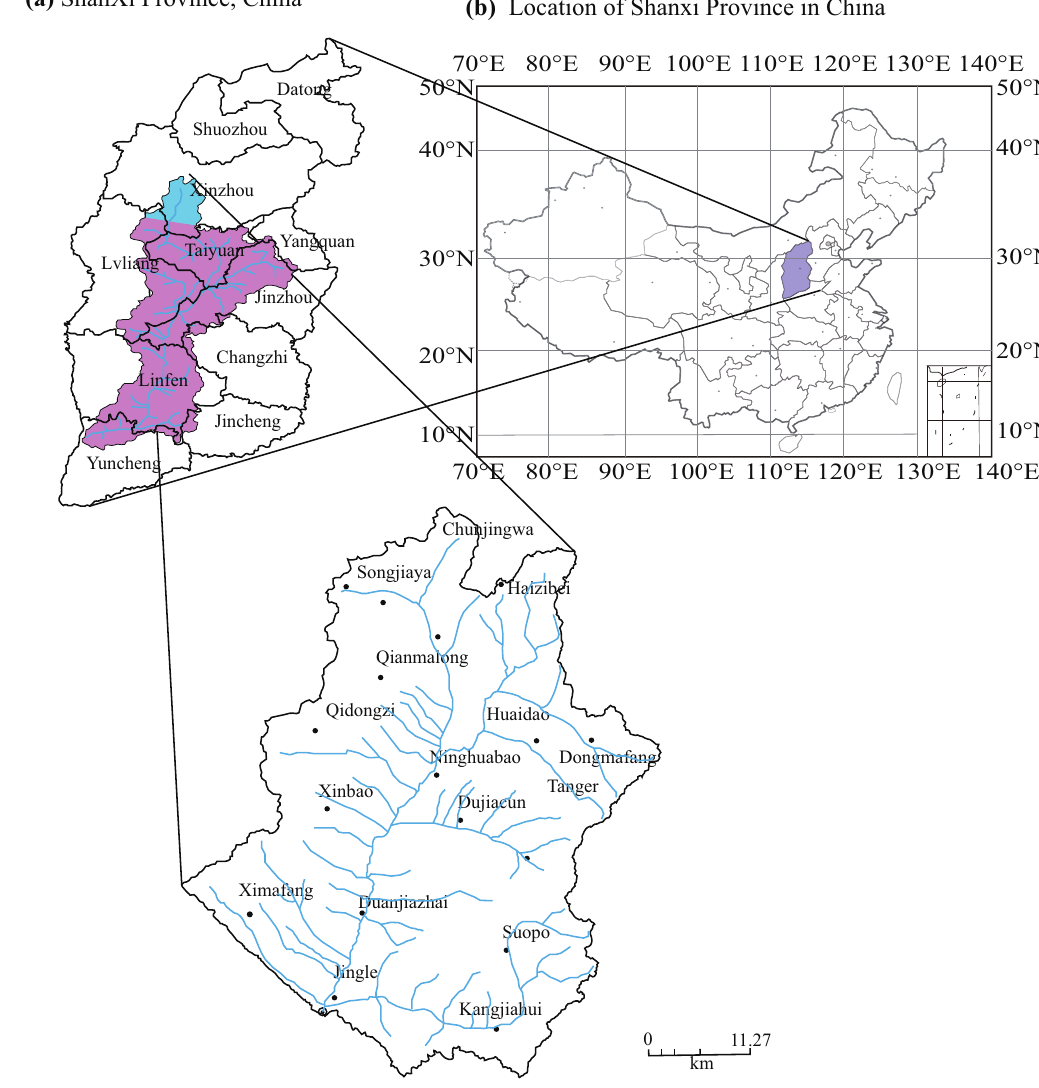
Figure 4. Location of the study site and the gauge stations. ( a ) Description of Fen River basin in Shanxi Province of China; ( b ) Description of Shanxi Province in Chian; ( c ) The control catchment of Jingle Station in Fen River and distribution of rainfall gauge